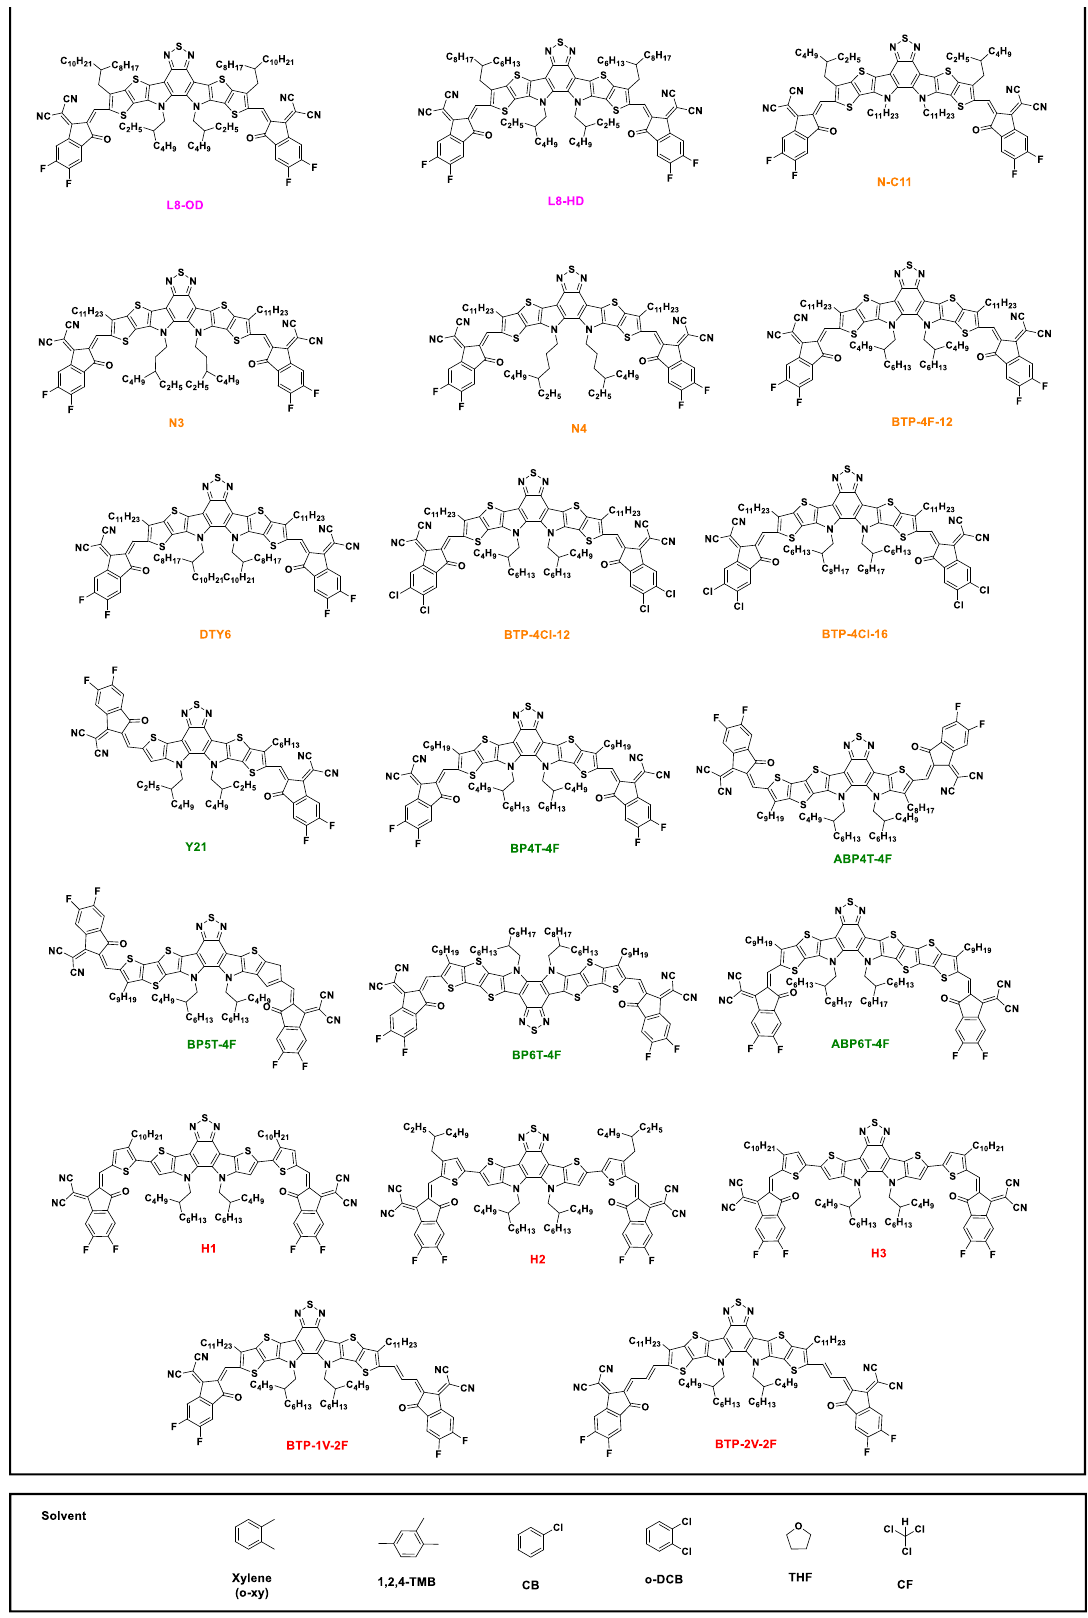
Figure 1. Main molecular structures used in the review article.